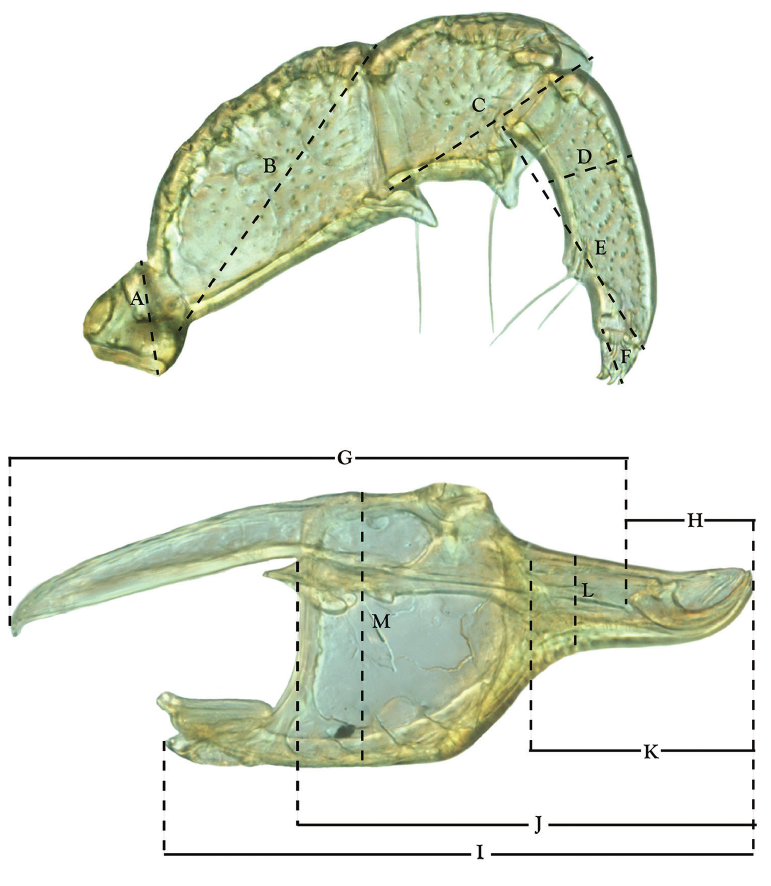
Figure 5. Gnathosomal measurements. Palpomeres – A trochanter length B femur length C genu length D tibia length E tibia width F tarsus length. Chelicerae – G cheliceral base length H fang length. Sub- capitulum – I ventral length J dorsal length K rostrum length L rostrum width M height. T. multiforma Habeeb, 1974